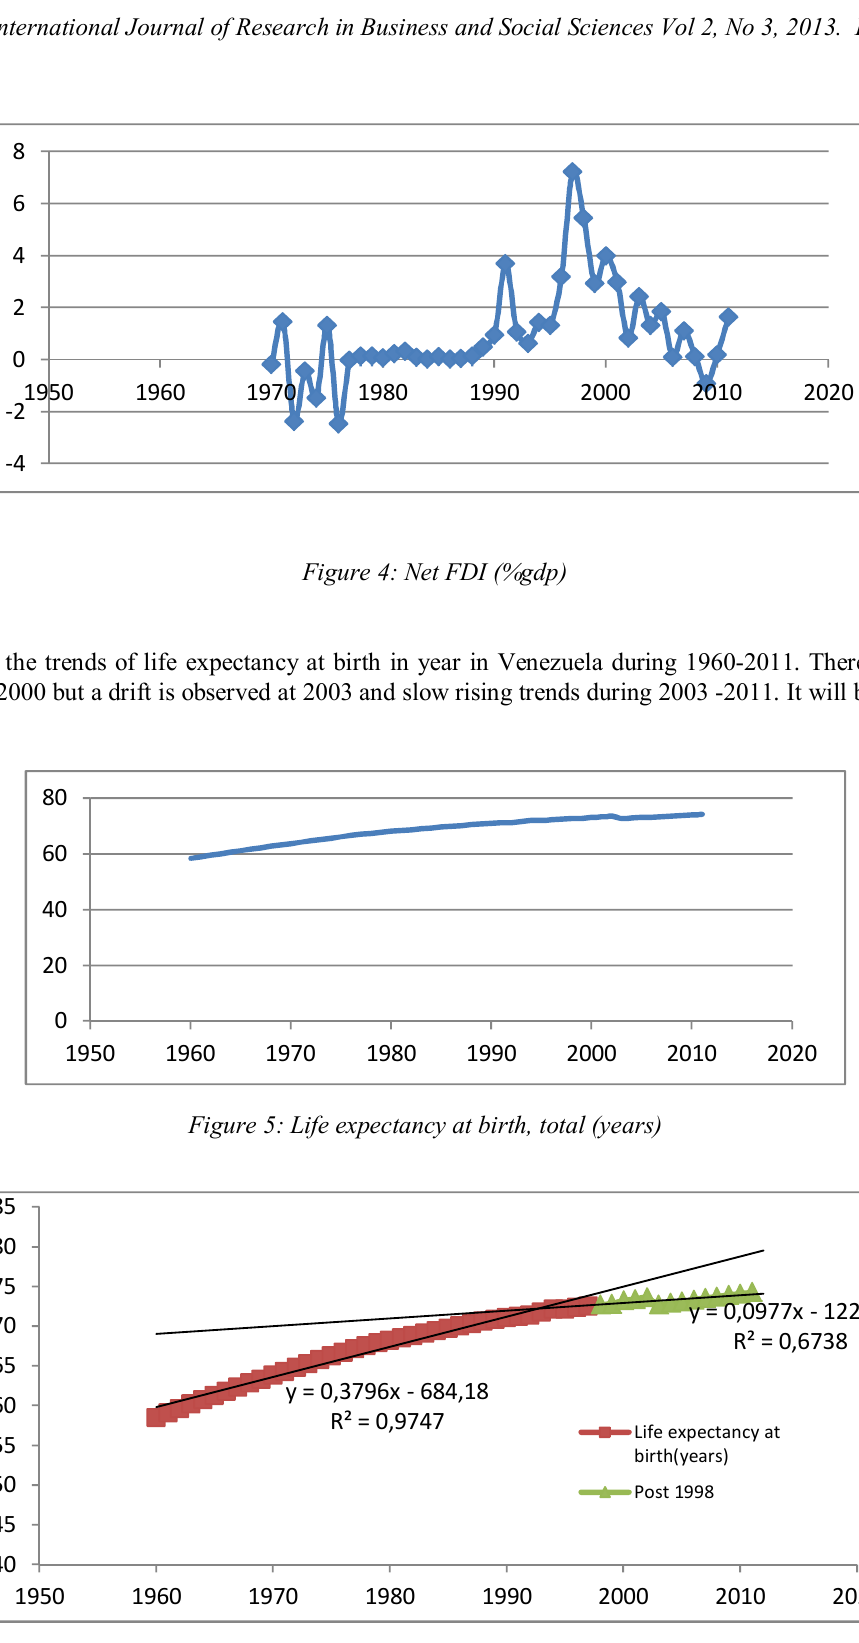
Figure 6: Life expectancy in Venezuela pre and post